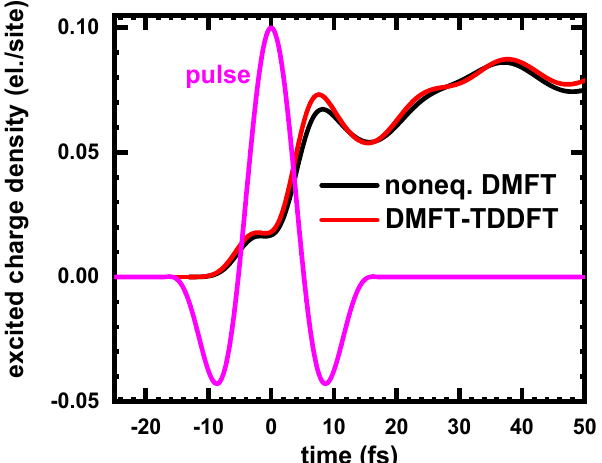
Figure 3. DMFT-TDDFT vs. nonequilibrium DMFT solution for the time-dependent excited charge density in one-band 3D Hubbard model on cubic lattice at U = 4 √ 6t when the system is perturbed by pulse (magenta curve). In the DMFT-TDDFT case, the atomic hydrogen s-orbital wave functions were used for the DFT input.